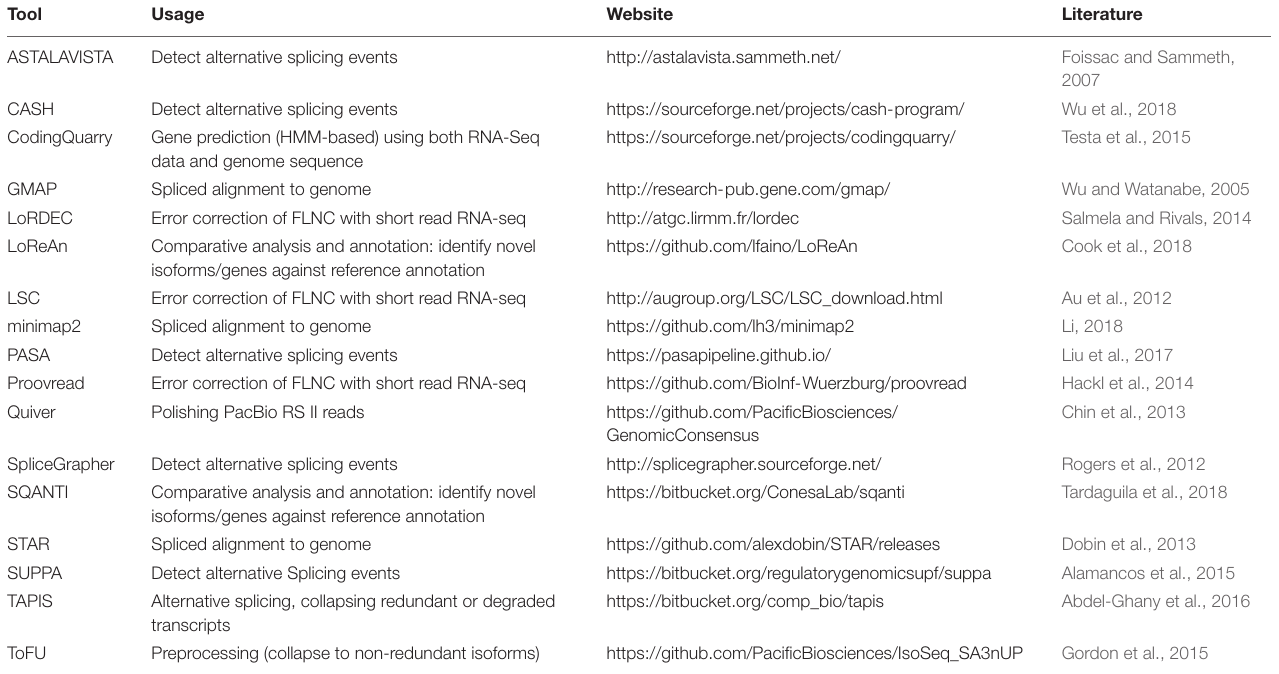
TABLE 1 | List of the Iso-Seq tools along with a brief description of their usage and related online links.